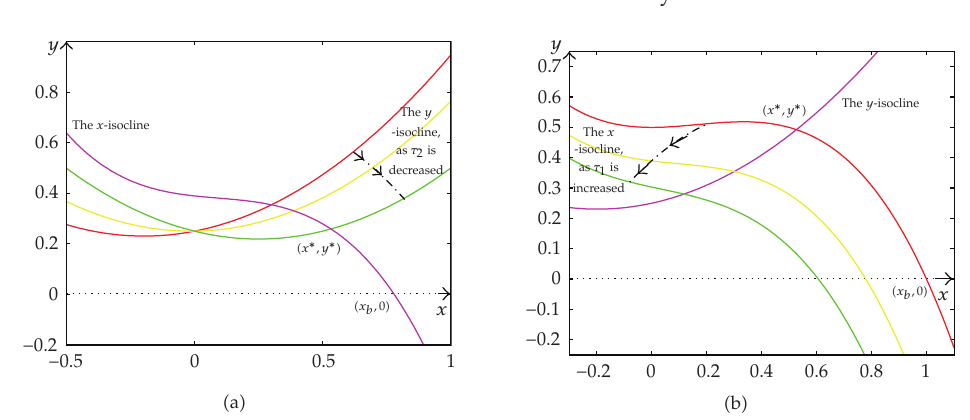
Figure 1: The x - and y -isoclines, for various of τ 1 and τ 2 , of the system (cid:4) 1.7 (cid:5) by removing the delays from the